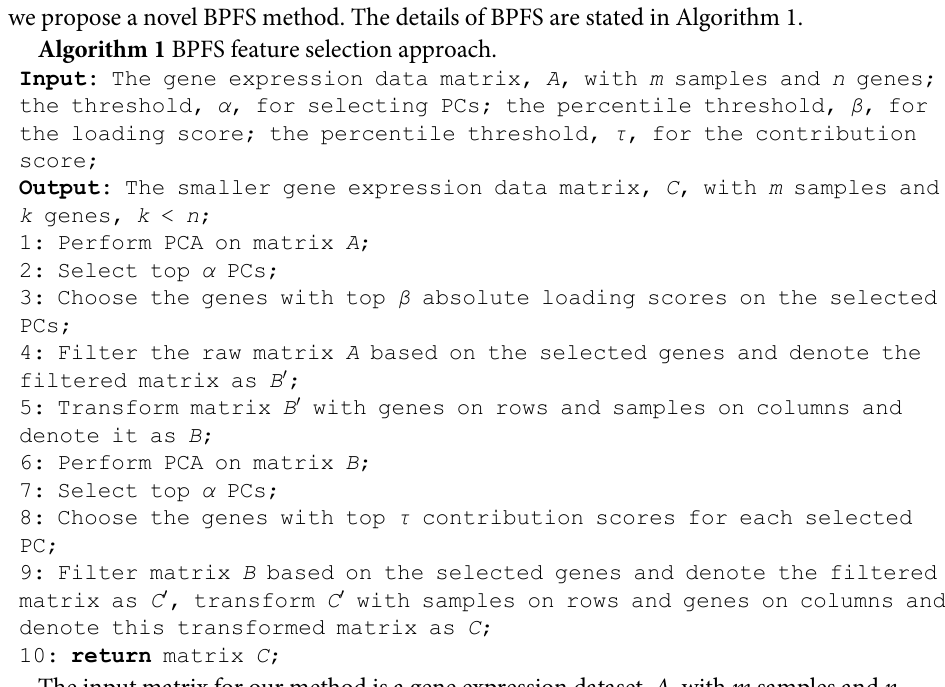
Algorithm 1 BPFS feature selection